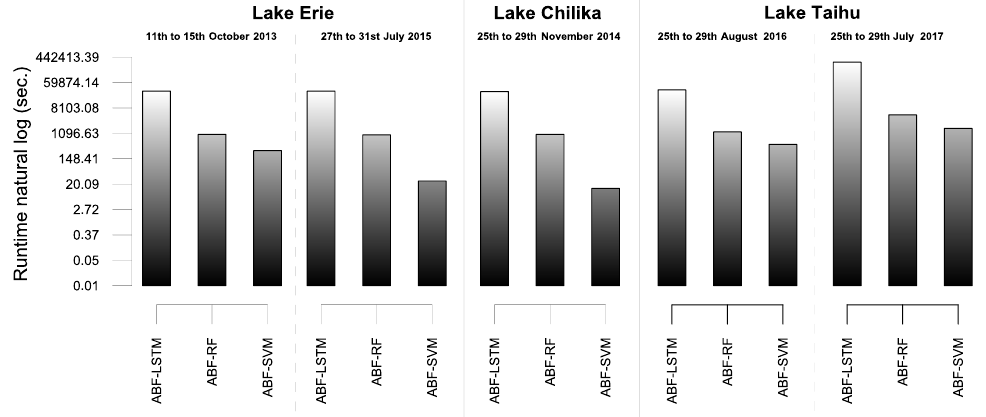
Figure 17. Computational run-times (average) for the study areas and evaluated